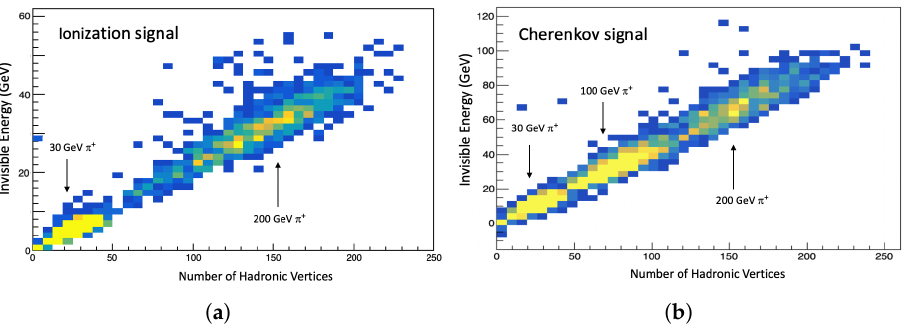
Figure 4. Invisible energy vs the number of hadronic vertices in a sampling calorimeter: ( a ) with ionization signal in Cu (17 mm) + Si (3 mm) and ( b ) with a Cherenkov signal in Cu (17 mm) + Quartz plate (3 mm) for 30 and 200 GeV π + s. “Invisible energy” is defined as the difference between the beam energy and the simple sum of the ionization signal or Cherenkov signal. “Hadronic vertex” is defined as a vertex of hadron-nucleus inelastic interaction excluding neutron-nucleus interaction. The energy scale of the signals was calibrated with